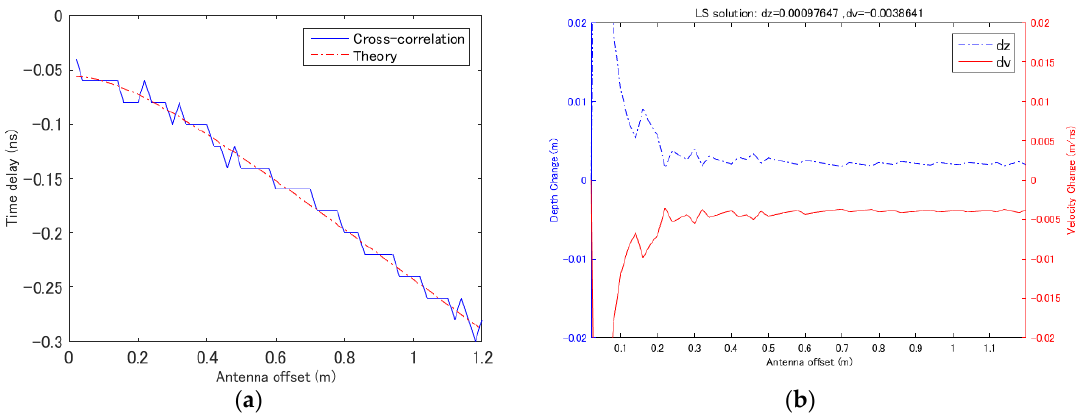
Figure 4. Simultaneous estimation of deviations in the propagation velocity and thickness with simulated data acquired by ray tracing. ( a ) Time delay estimation using the cross-correlation method. ( b ) Estimation results obtained using the proposed method with two antenna pairs; one with 0.05 m offset and all other antenna pairs. The least squares solution is given at the top of the figure.